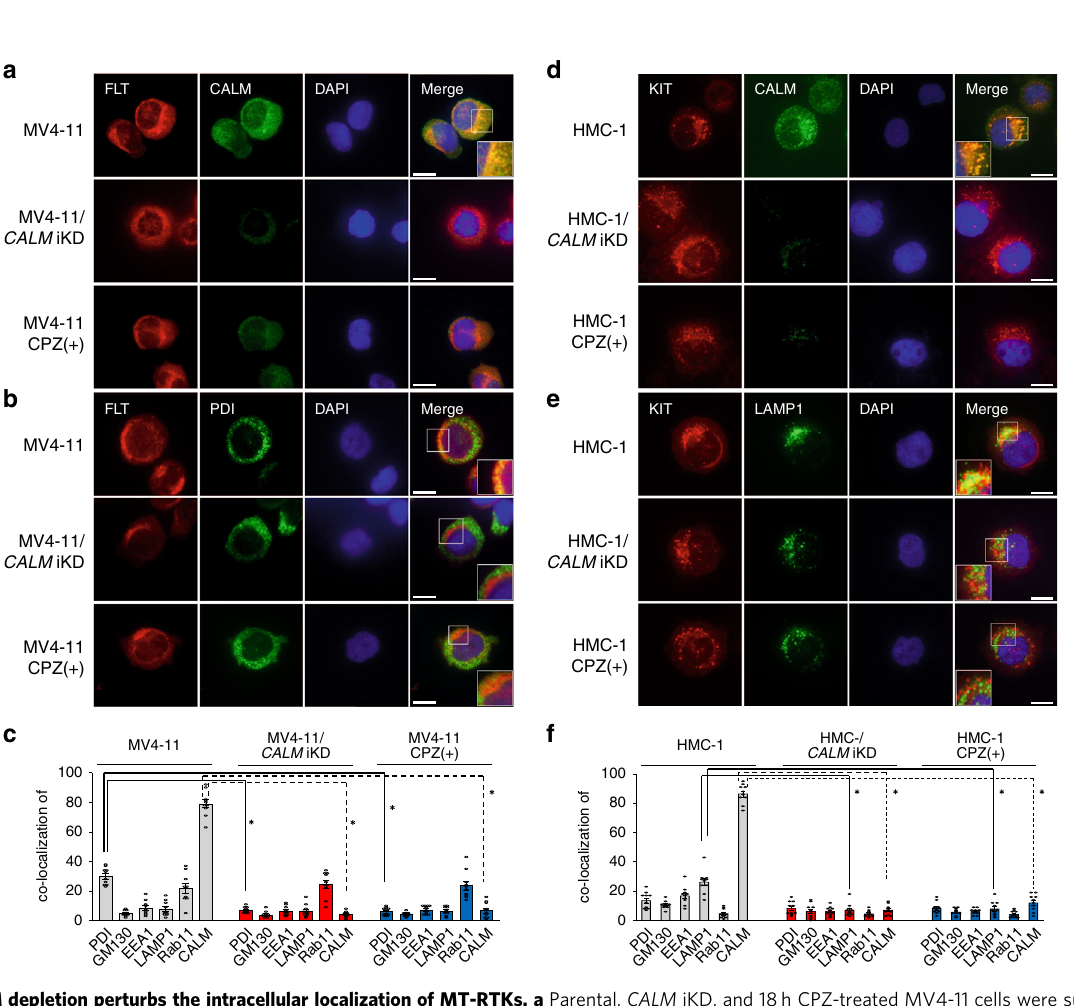
Fig. 3 CPZ selectively targets AML cells with MT-RTKs mainly through CALM inhibition. a Various leukemia cell lines were cultured in the presence or absence of 7.0 μ M serotonin receptor antagonist (METHIO) or dopamine receptor antagonist (THIO) for 72 h and viable cell numbers were evaluated. Relative growth ratio was calculated using respective untreated cells as a reference. Data indicates the mean ± SEM from three independent experiments. b After 72 h treatment with THIO, METHIO, or CPZ, apoptotic cells were detected as Annexin V-positive cells. The results obtained from the indicated cells are shown as the mean ± SEM from four independent experiments. c HMC-1 and MV4-11 cells were cultured with or without CPZ at the indicated concentrations for 24 h. Immunoblot analyses were performed with the indicated Abs. Densitometry analysis was carried out by Image Quant TL, and data are from two independent experiments. d HMC-1 cells were cultured with 7.0 μ M CPZ for the indicated times, and CALM mRNA levels were quanti fi ed by qRT-PCR. Figure shows the mean from two independent experiments. e The relative growth rates of HMC-1/ CALM iKD (left panel) and MV4-11/ CALM iKD (right panel) cultured with or without 7.0 μ M CPZ were evaluated with HMC-1/SCR and MV4-11/SCR as references, respectively. The results indicate the mean ± SEM from three independent experiments. One-way ANOVA multiple comparisons with Bonferroni correction, * p = 0.0005, ** p = 0.0006, *** p < 0.0001.